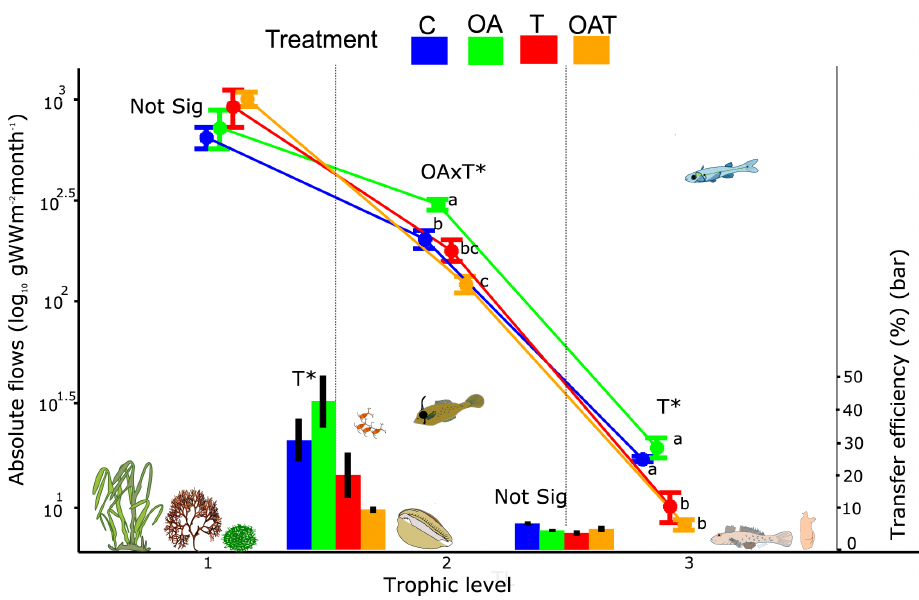
Fig 1. The effects of future climate on absolute flows and transfer efficiency between successive trophic levels of the mesocosm food web. Absolute flows, shown as line diagrams, refer to the total amount of energy that flows to higher trophic levels through consumption (log10 g Wet Weight/m 2 /month) aggregated by trophic level. The first trophic level shows flows originating from both the primary producers and detritus, which are transferred to the second and third trophic level through consumption by herbivores and carnivores, respectively. Transfer efficiency, presented as bar charts, refer to the ratio at which absolute flows are transferred from one trophic level to the next. Mean ± SE are based on n = 3 mesocosms. Significant effects ( p < 0.05) within trophic levels are based on two-way ANOVAs (df = 1,8) and are indicated with asterisks. See S1 Table for statistical test outcomes. Means with different lower-case letters indicate significant differences among treatments based on posthoc tests corrected for false discovery rate and done separately for different trophic levels. The distribution of organisms within the mesocosms is reflected as their vertical position inside the graph (ranging from the bottom of the mesocosm to the surface of the water column). Species cliparts were obtained or modified from Openclipart (https://openclipart.org/). C, control; not sig, not significantly different; OA, elevated CO 2 ; OAT, elevated CO 2 and temperature; T, elevated